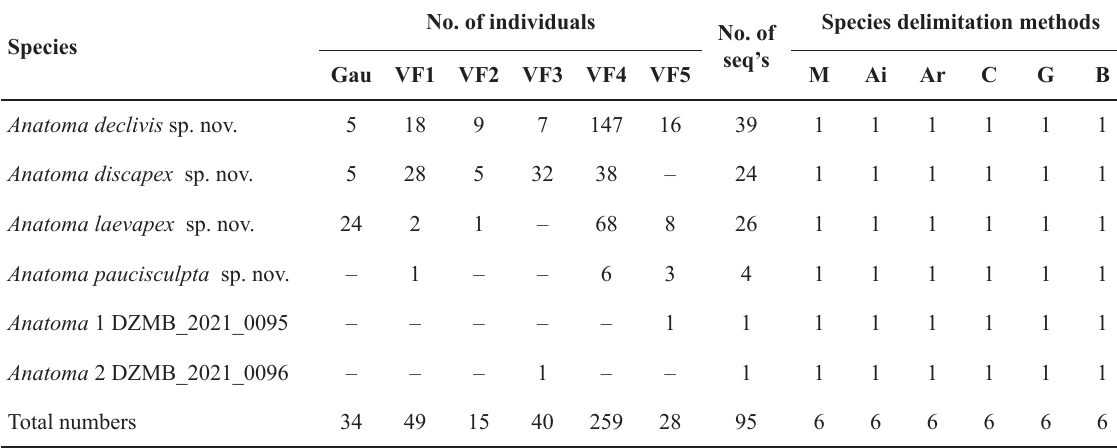
Table 3. The list of taxa identified in the study presented for the sampled location: Gauss vent field (Gau), Vent field (VF). Unidentified or juvenile specimen are not named (see Supp. file 1: Table S1). Selected sequences for COI, morphological delimitation (M), MOTUs for ABGD (Ai, initial and Ar, recursive partition), CD-Hit (C), GMYC (G) and bPTP (B).